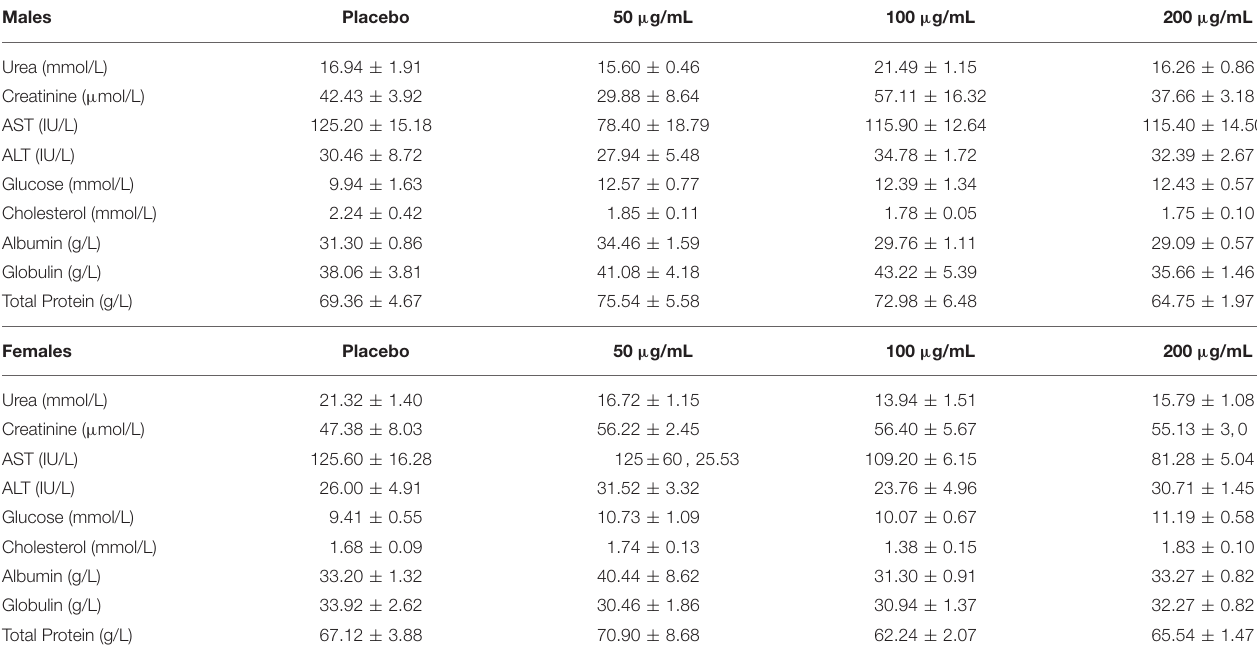
TABLE 2 | Biochemistry data from Wistar rats vaccinated with repeated injections of StreptInCor at 50, 100 or 200 µ g/mL doses compared with placebo. Males Placebo 50 µ g/mL Urea